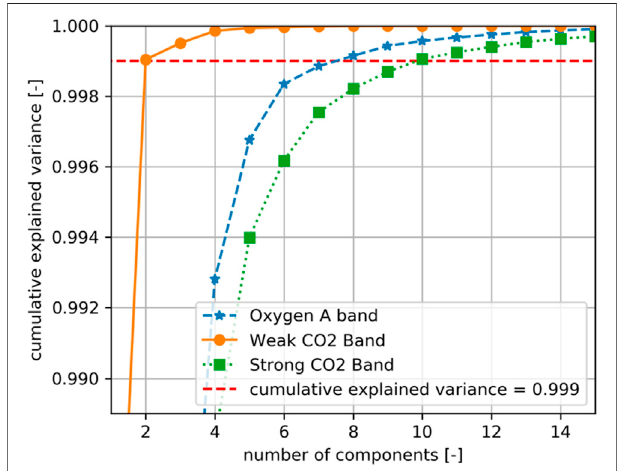
FIGURE 2 | Cumulative explained variance of the fi rst 15 principal components for the three OCO-2/3 instrument bands. O2A-band is shown with blue stars, WCO2-band with orange dots, and SCO2-band with green squares. Note, for clarity, cumulative explained variance is shown only from 0.99 to 1.0 and, therefore, omits data points that have a cumulative explained variance of less than 0.99.